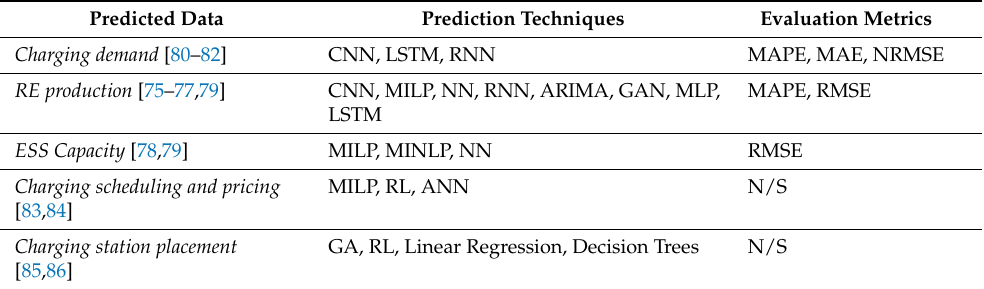
Table 6. Classification of predicted